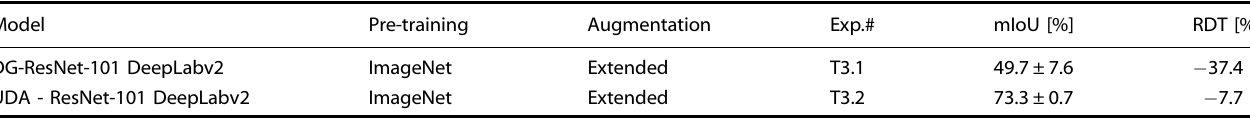
Table 4. Performance of the DeepLabv2 model trained on the source domain evaluated on the target 3 domain along with the UDA reached performance.